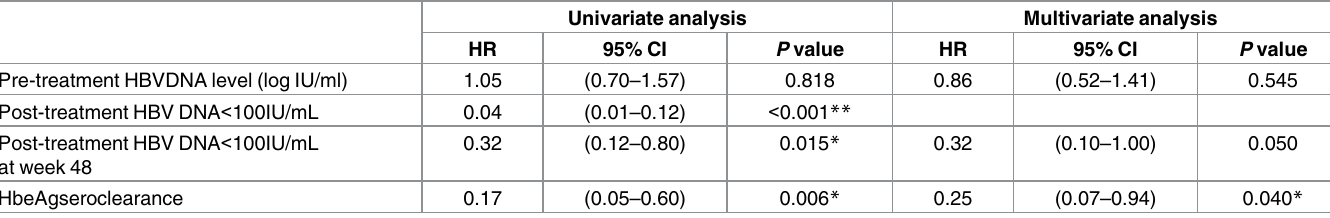
Table 2. Univariate and multivariate analysesof factors associated with virological breakthrough.